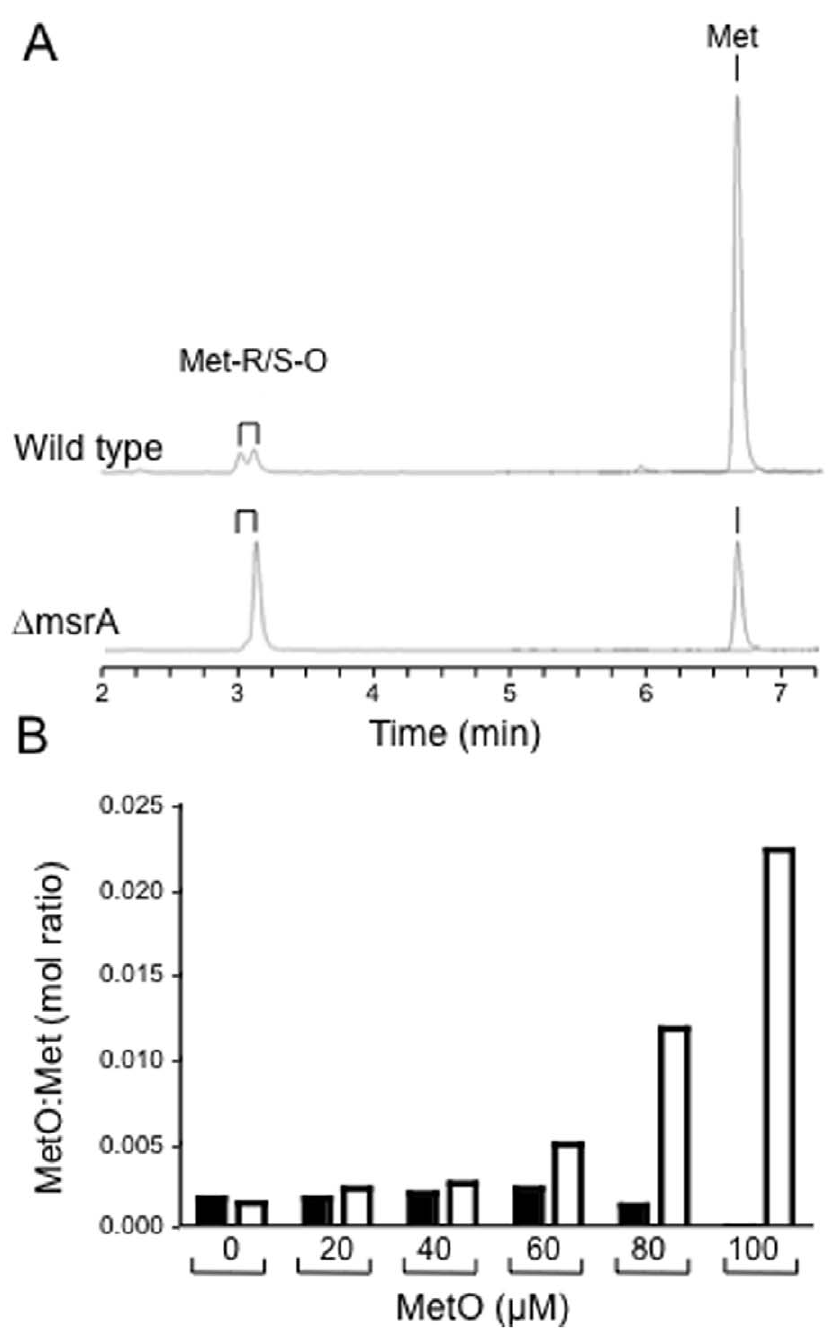
Figure 3. LC-MS quantification of intracellular MetO and Met levels in L.major grown in varying concentrations of Met and MetO. A. Abundance of free MetO (comprising a doublet of Met-S-O/Met-R-O isomers) and Met in total extracts of wild type (upper panel) and D msrA (lower panel) promastigotes cultivated in media containing 80 m M MetO and 20 m M Met. B. Ratio of MetO to Met levels in L. major wild type (black columns) and D msrA (white columns) grown in varying concentrations of